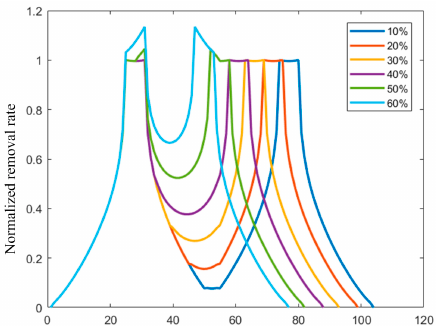
Figure 8. Cross-section diagram of the removal quantity of the polishing paths with different overlap rates.